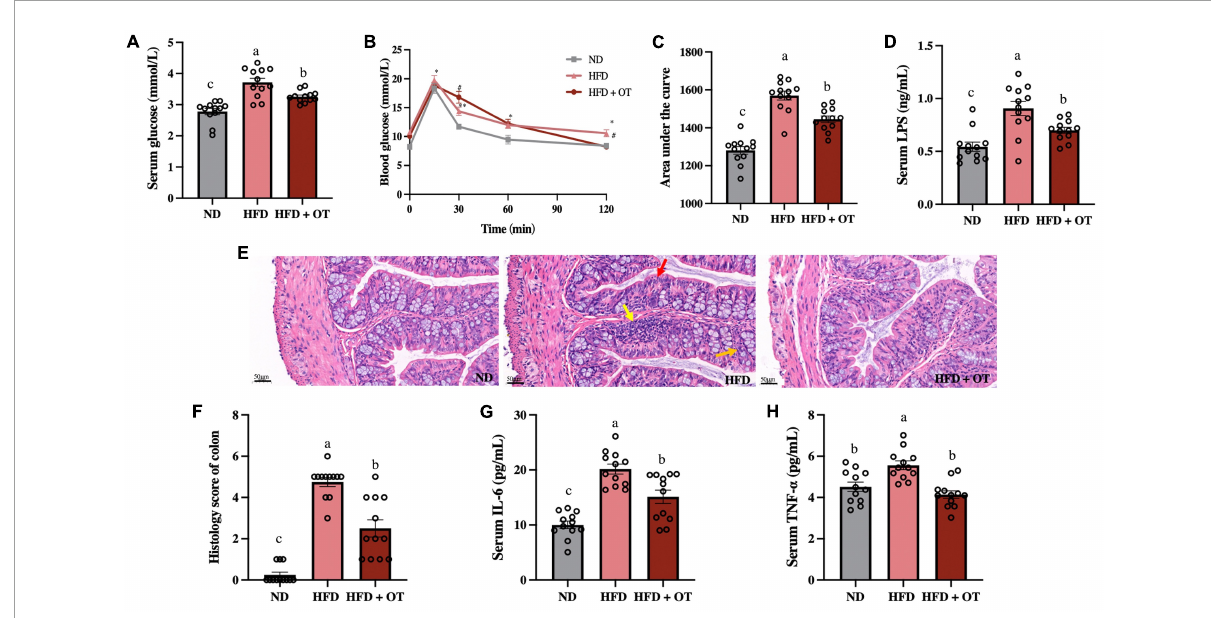
FIGURE4 Oolong tea improved glucose tolerance and inflammatory disorder in obese mice. (A) Serum glucose levels. (B) Oral glucose tolerance test. (C) Calculated AUC for OGTT. (D) Serum LPS levels. (E) H&E staining sections from colon tissue (scale bar, 50 µ m). (F) Histology score. (G) Serum IL-6 levels. (H) Serum TNF- α levels. Data are expressed as mean ± SEM ( n = 12). (A,C,D,F–H) The mean value with different letters indicates significant differences ( p < 0.05). (B) HFD vs. ND: ∗ p < 0.05, ∗∗ p < 0.01; OT vs. HFD: # p <